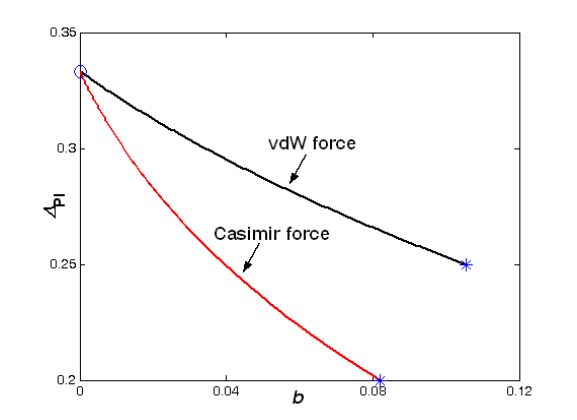
Figure 3 . Comparison between vdW and Casimir forces with variation of the pull-in displacement Δ with parameter b . PI